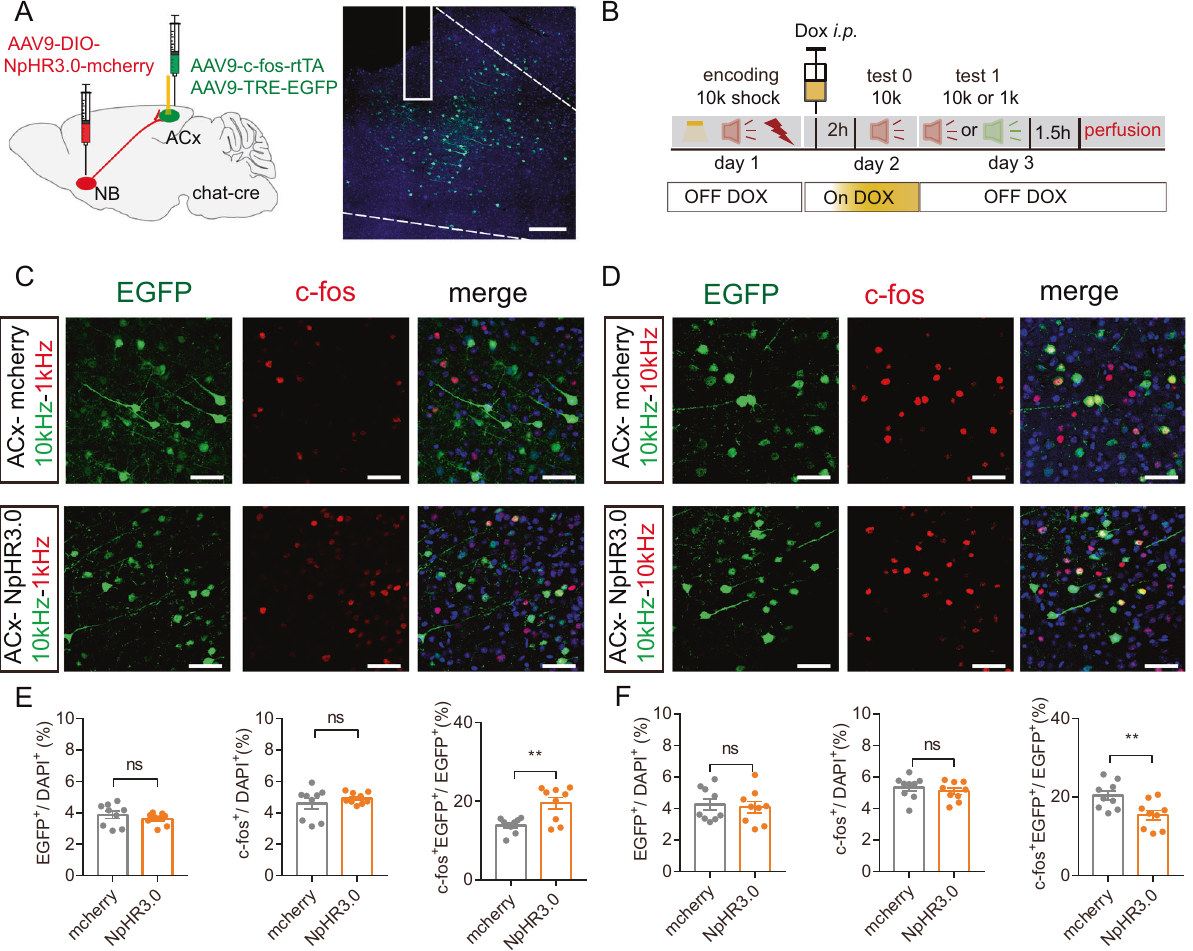
Fig. 4 Cholinergic signaling in fl uences the ACx neural activity to modulate tone-responsive neurons during the encoding stage. A Left: schematic of virus injection. In ChAT-cre mice, AAV9-DIO-NpHR3.0-mCherry was infused into the NB. The viruses AAV9-c-fos-rtTA and AAV9- TRE-EGFP were infused into the ACx. Right: representative confocal images of in the ACx. B Behavioral design. C – F Representative confocal images ( C and D ) and the statistical numbers ( E and F ) of EGFP + , c-fos + , and EGFP + c-fos + immuno fl uorescent cells in the ACx during 1 kHz retrieval stage ( C , E ) or 10 kHz retrieval stage ( D , F ) in mice under inhibition of ACx-projecting cholinergic neurons of NB at the encoding stage. (Blue, DAPI; green, the activated ACx cells at test 1 in day 2 that were marked by EGFP; red: the activated ACx neurons marked by c-fos in mice that are given 1 kHz tone ( C ) or 10 kHz tone ( D ) at day 3. Scale bar: 50 μ m. In E and F , the NpHR3.0 and mCherry groups displayed similar percentages of EGFP + and c-fos + cells among DAPI + cells ( n = 9 images from three mice). In E , the NpHR3.0 group displayed a higher percentage of EGFP + c-fos + /EGFP + cells than mCherry group during the 1 kHz retrieval test ( n = 9 images from three mice). In F , the NpHR3.0 group displayed a lower percentage of EGFP + c-fos + /EGFP + cells than mCherry group during the 10 kHz retrieval test ( n = 9 images from three mice). Statistical tests: E and F , unpaired two-tailed t -test. ns not signi fi cant; * P < 0.05, ** P < 0.01, *** P < 0.001. Data are presented as mean ±